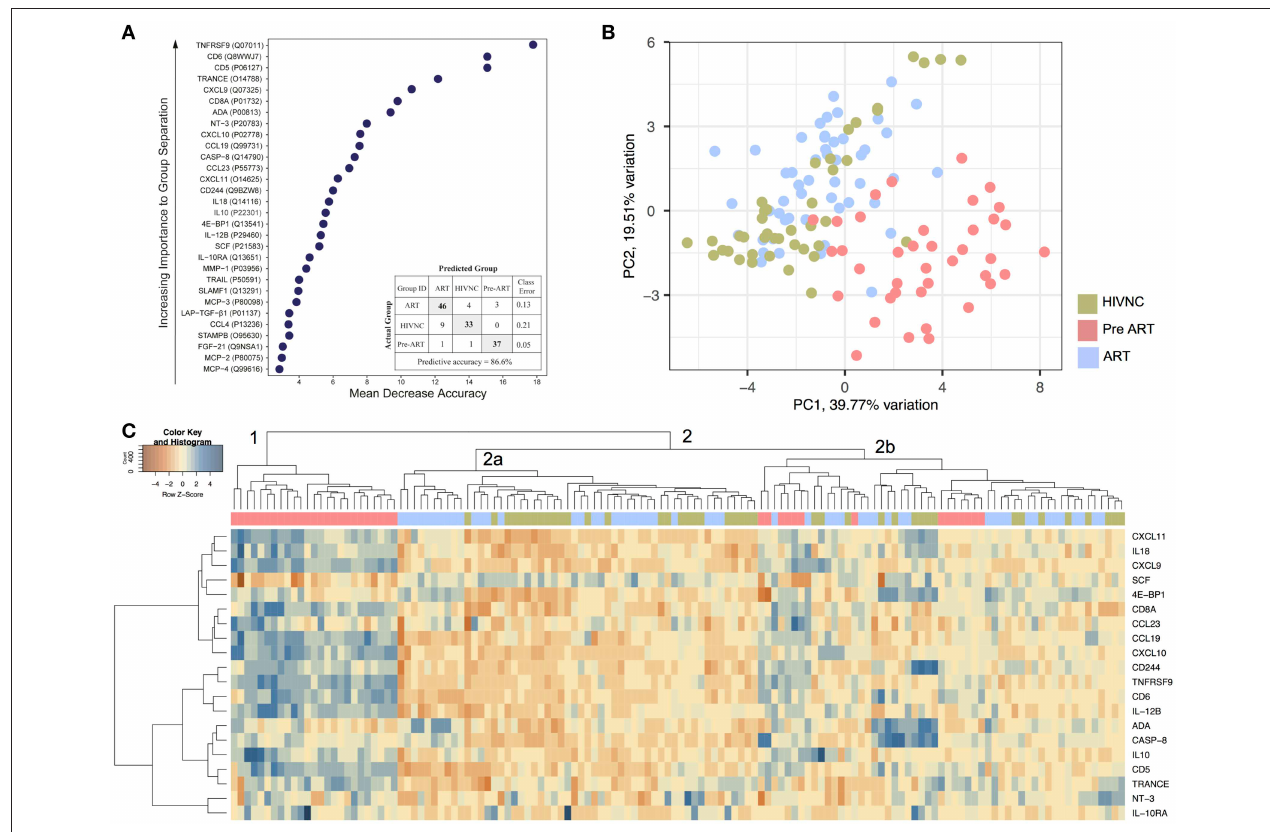
FIGURE 3 | Plasma inflammation markers. (A) The random forest (RF) analysis of soluble factors resulted in predictive accuracies of 86.6% for HIVNC, Pre-ART, and ART. The soluble factors importance plots display the top 30 metabolites, which most strongly contribute to the groups’ separation for HIVNC, Pre-ART, and ART. (B) Principal component analysis using PCAtool indicating grouping in different disease categories. (C) Hierarchical clustering analysis of ANOVA of top 20 differentially expressed proteins with false discovery rate (FDR) <